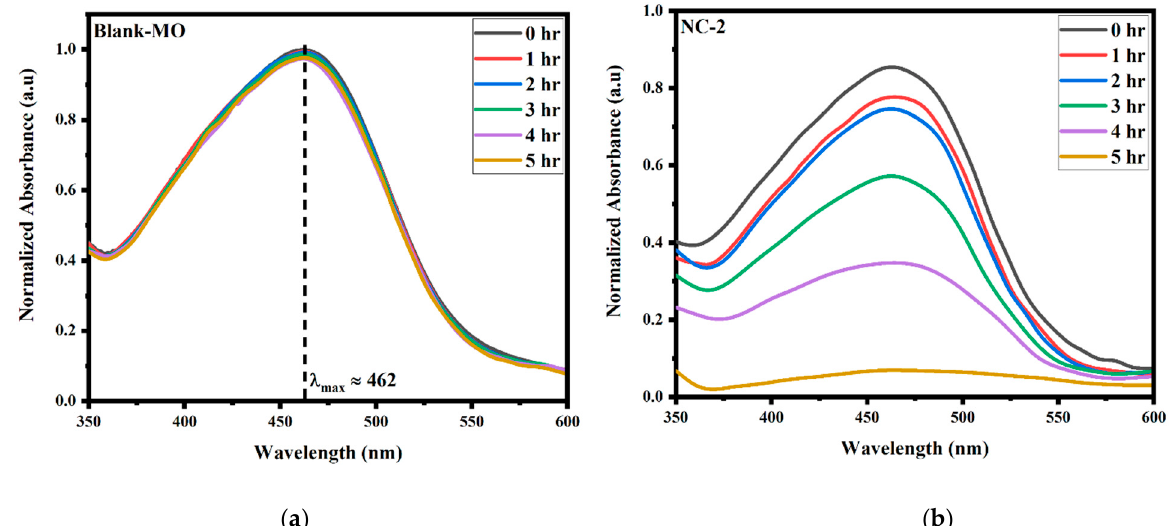
Figure 6. UV/visible spectral information for ( a ) Blank and ( b ) NC-2 under illumination.